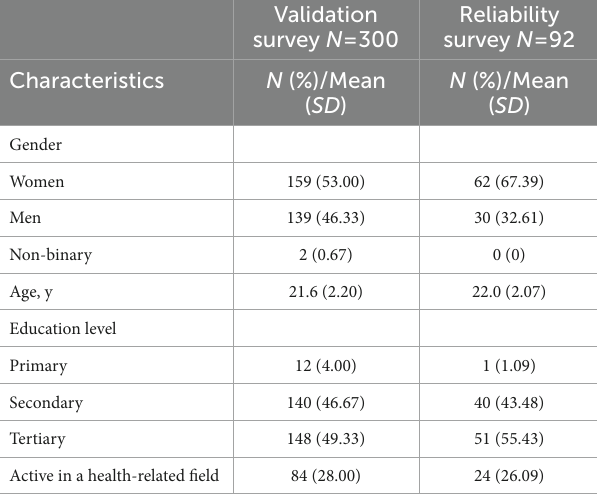
TABLE 1 Demographic characteristics of participants in the validation and reliability